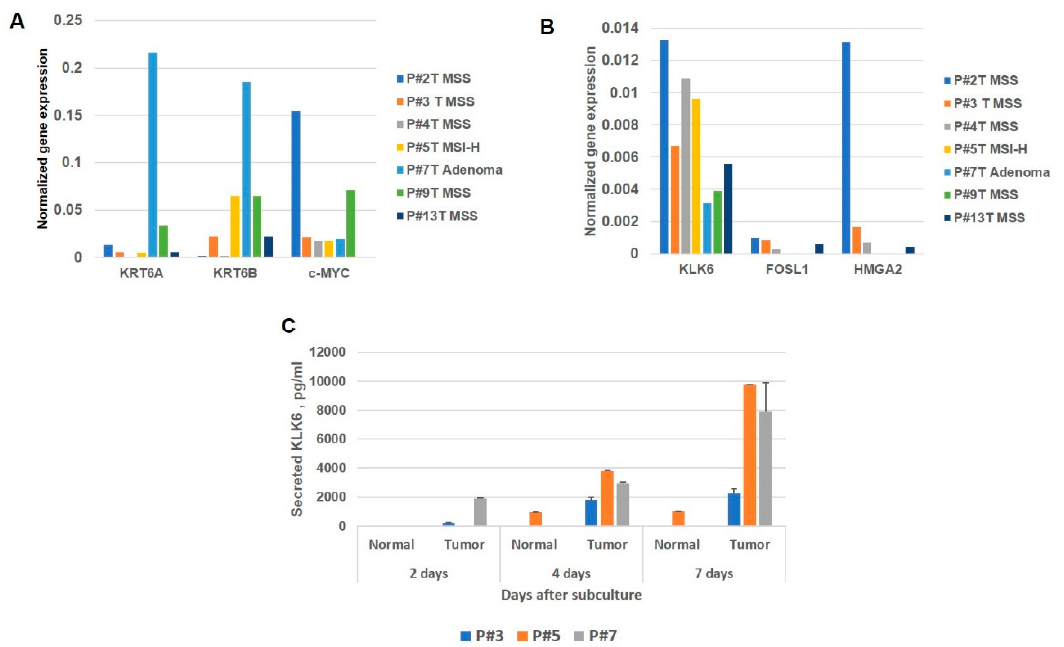
Figure 6. Evaluation of the transcript levels of selected co-expressed genes and KLK6 secretion in the CRC patient-derived organoid cultures. ( A ) KRT6A, KRT6B and c-MYC transcript levels. ( B ) KLK6, FOSL1 , and HMGA2 transcript levels. ( C ) Levels of secreted KLK6 in the conditioned media of the tumor organoid cultures by ELISA.